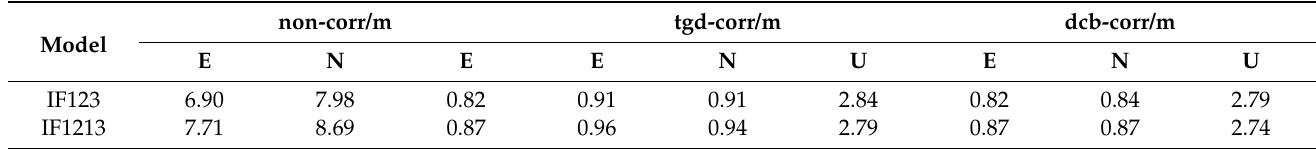
Table 3. Average positioning accuracy of SPP for IF123 and IF1213